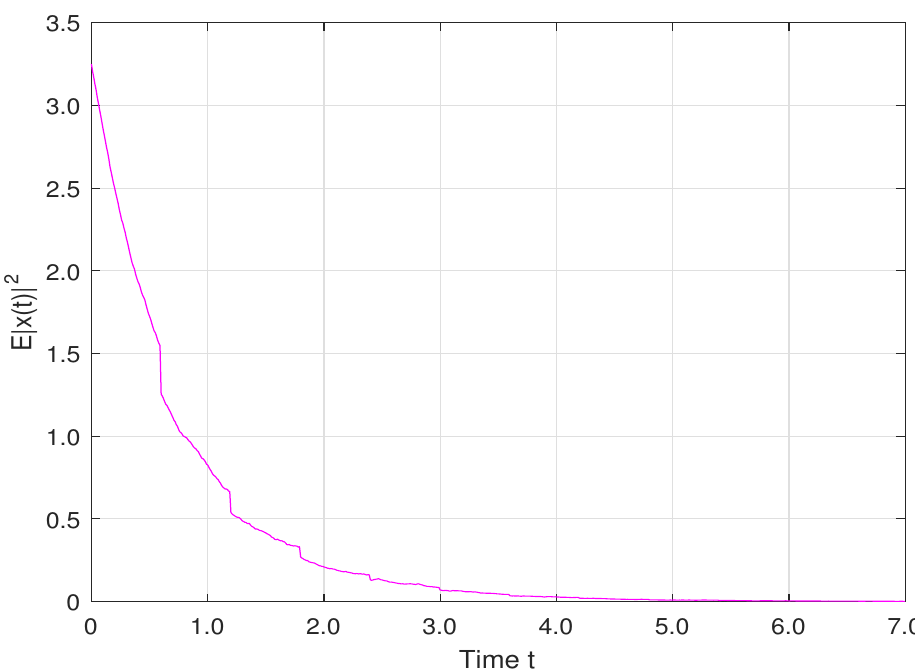
Figure 2. The curve of mean-square of 1000 paths with